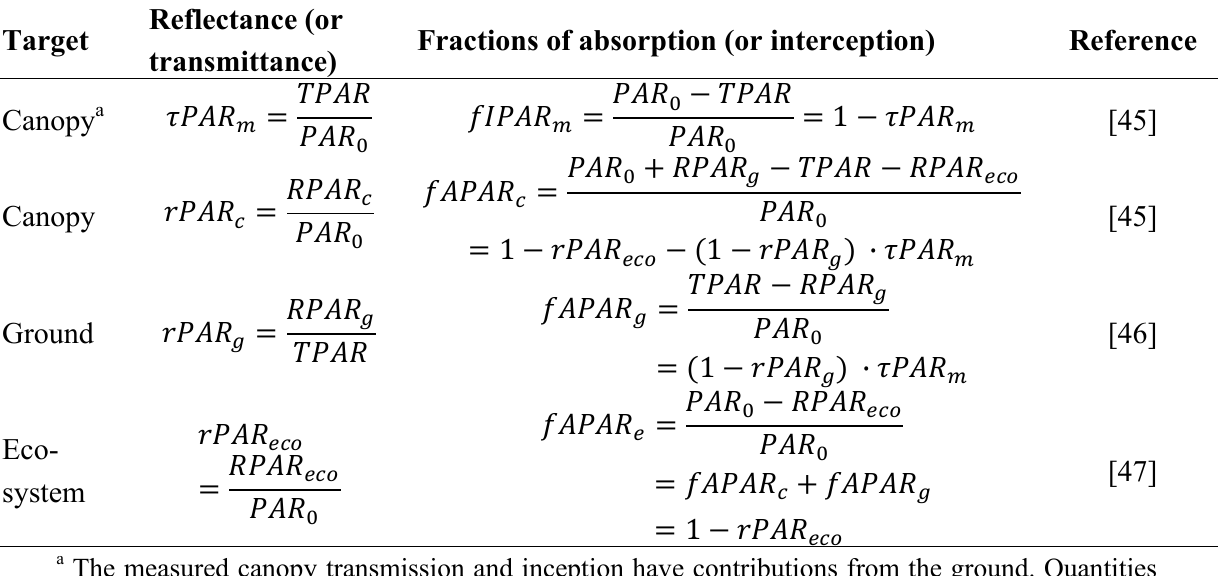
Table 6. Formulae for fractions of PAR absorption and interception, as well as for PAR reflectance and transmittance. (cid:2028)(cid:1842)(cid:1827)(cid:1844) is the measured canopy transmittance, (cid:1844)(cid:1842)(cid:1827)(cid:1844) (cid:3040) purely canopy-reflected PAR which is a part of the total reflected PAR, (cid:1844)(cid:1842)(cid:1827)(cid:1844) subtracting fluxes that directly reach the sensor from ground reflection, or after canopy transmission. (cid:1844)(cid:1842)(cid:1827)(cid:1844) is the ground reflected PAR, including reflection from bare soil and (cid:3034) ground vegetation below the tree canopy. See Section 2.2 for explanation of measured PAR